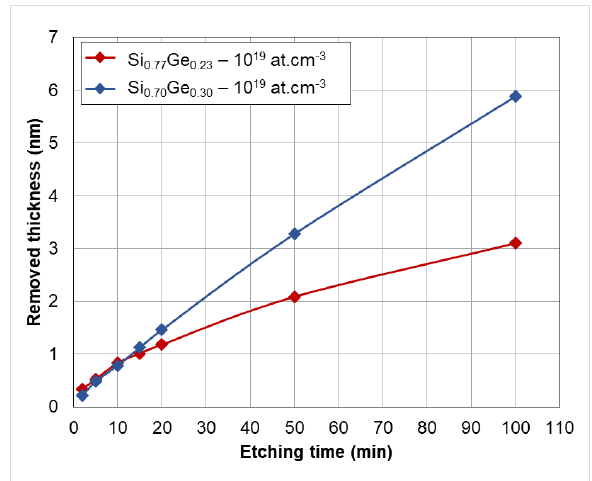
Figure 2: Removed SiGe thickness (measured by ellipsometry) as a function of etching time for two different Ge contents. After the first 15 min, the etch rate increases with Ge